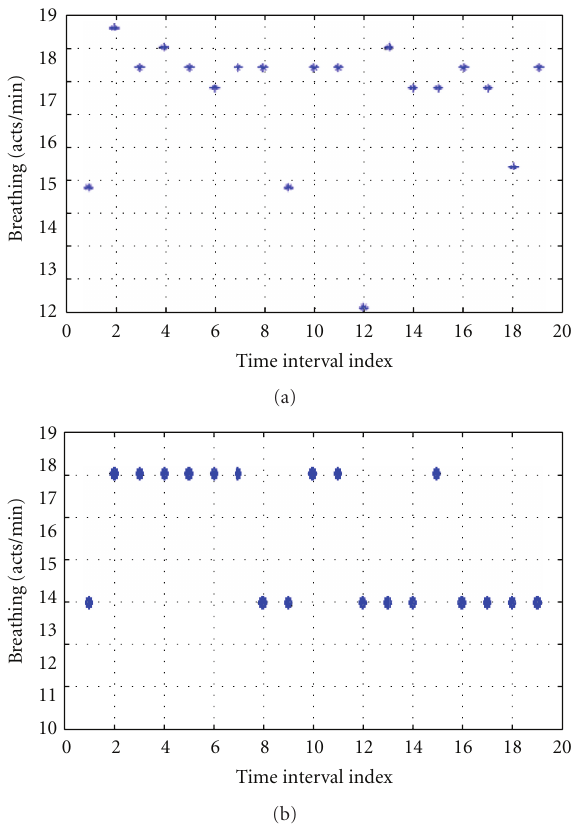
Figure 5: Comparison between the dataprocessing approaches for the breathing activity monitoring: (a) first data-processing approach; (b) seconddata-processing approach.